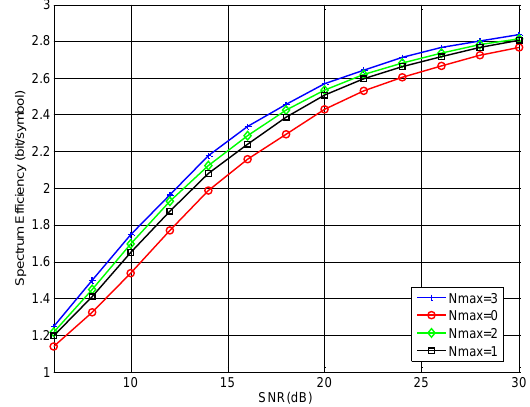
Fig.6 Spectral efficiencies of cross-layer design for physical layer network coding system with varying from 0 to 3